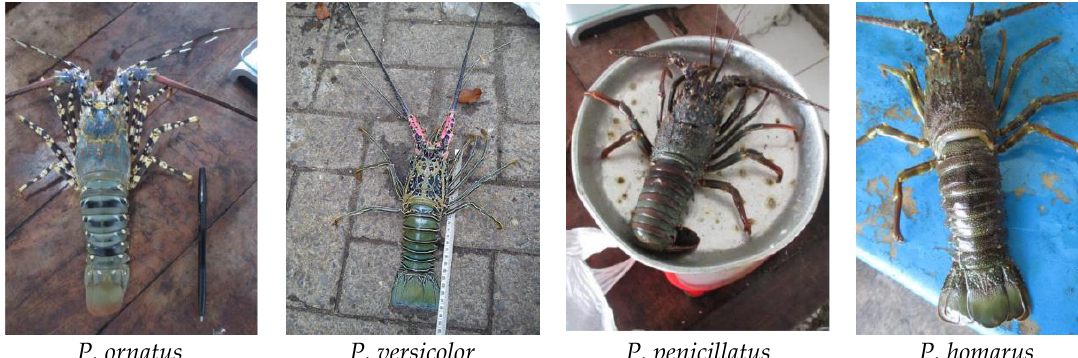
Figure 2. Lobster type in Palabuhanratu Bay [30].